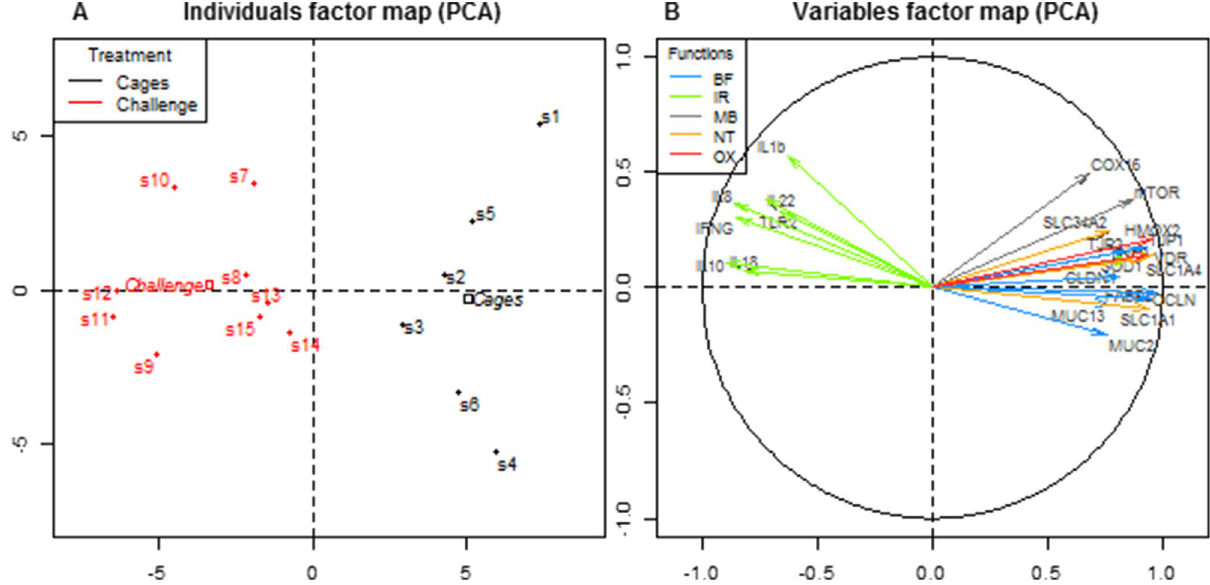
Figure 1. PCA representations of intestinal gene expression data in ileum chicken broiler samples ( A ) The samples dot plot; ( B ) variables arrow